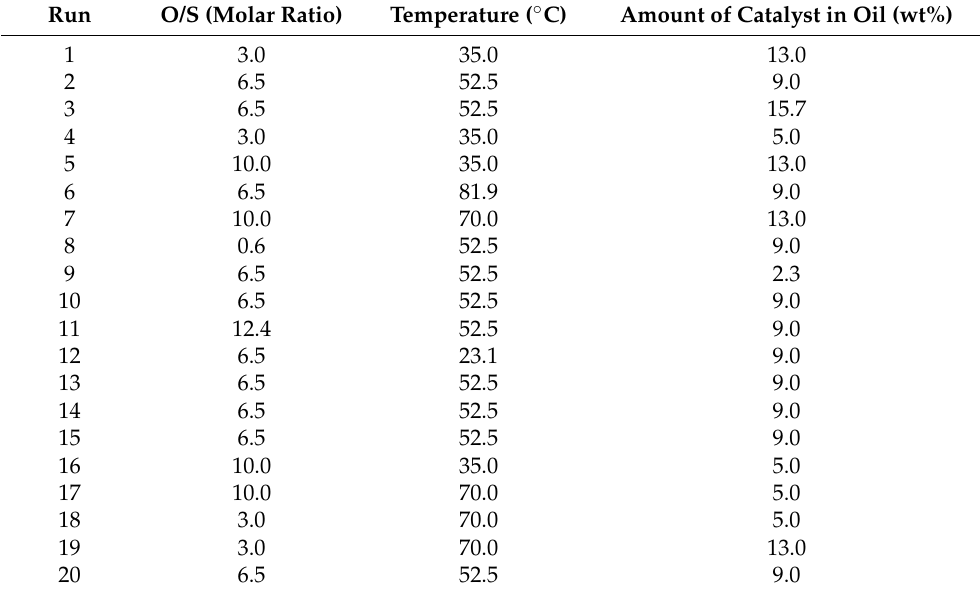
Table 2. Design of experiment for process